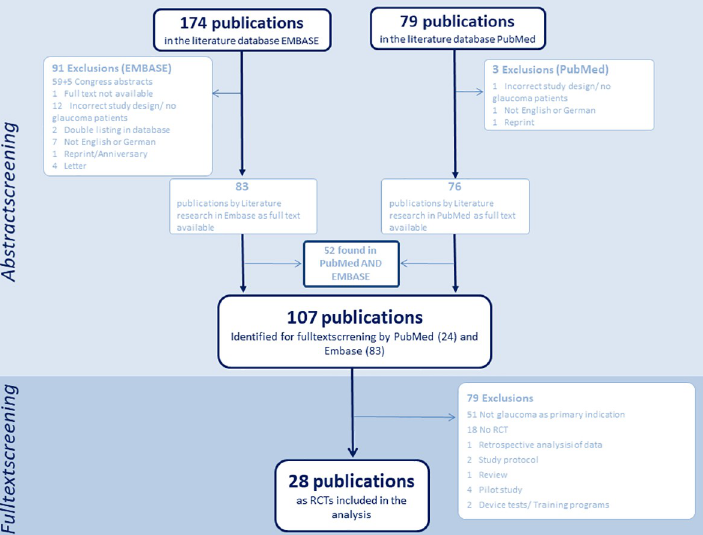
Fig 3. Glaucoma flow chart. Flow chart on screening for publications of trials on glaucoma treatment.